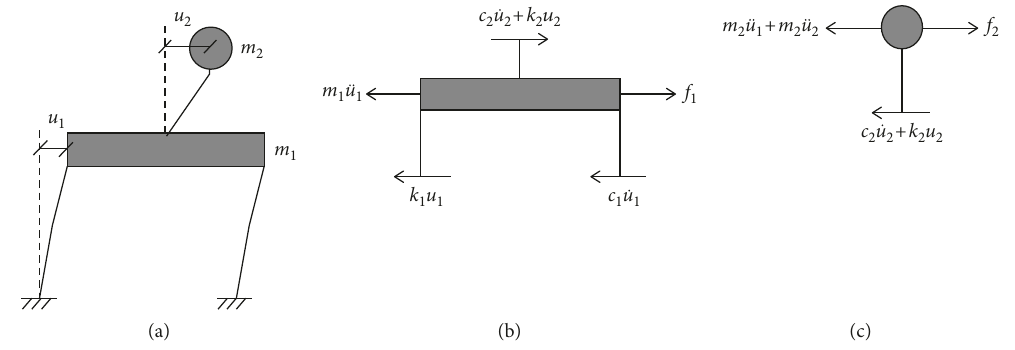
Figure 1: Schematic and force analysis of 2-DOF series model.